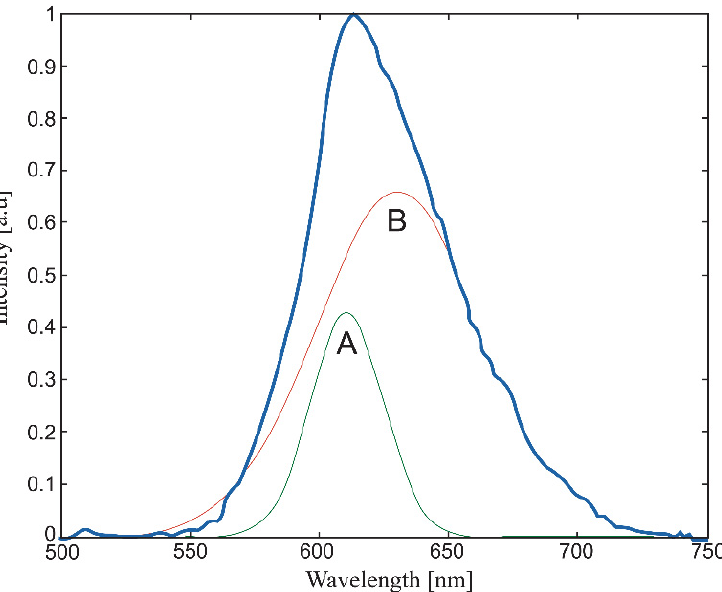
Figure 5. Photoluminescence spectrum of pure ZnSe. A, B are the emission bands, the blue line represents the sum of bands A plus B. The excitation was performed at 457.9 nm. Table 3. Temperature dependence of the bands for ZnSe.